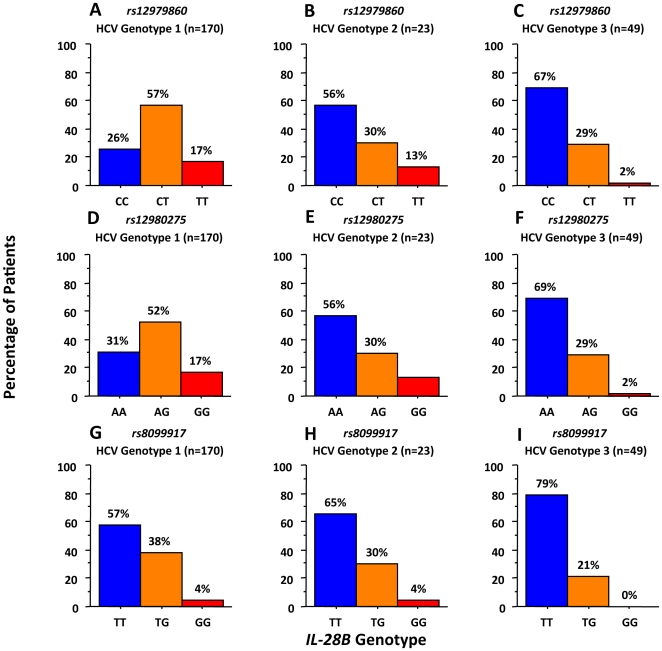
Frequency distribution of IL28B variants in relation to HCV genotypes 1-3.